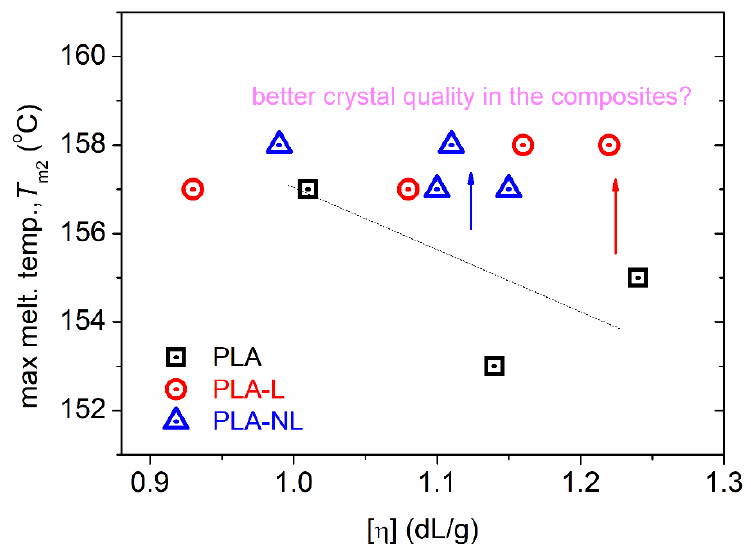
Figure 7. The [η] depe ndence on higher melting temperature, T m2 , for all samples. Figure 7. The [ η ] dependence on higher melting temperature, T m2 , for all